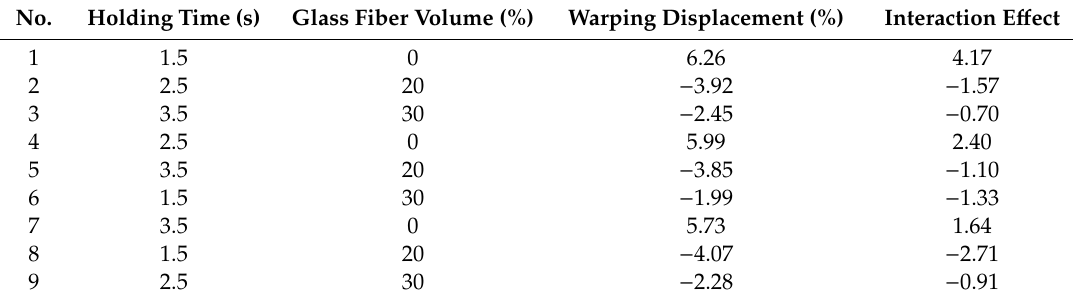
Table 1. Relationship of Interaction e ff ect and Warping displacement.